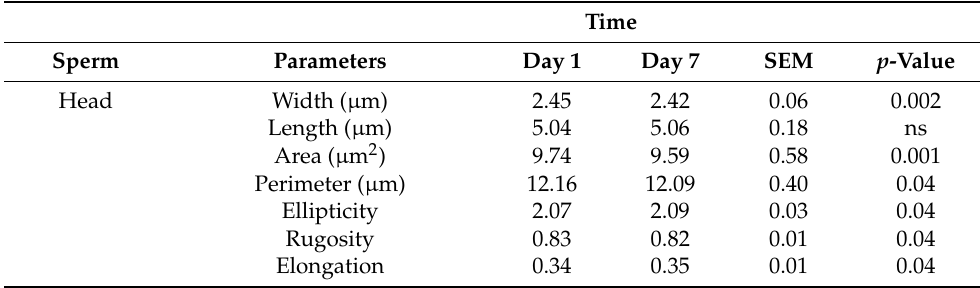
Table 5. Bottlenose dolphin ( Tursiops truncatus ) morphometric sperm parameters comparison